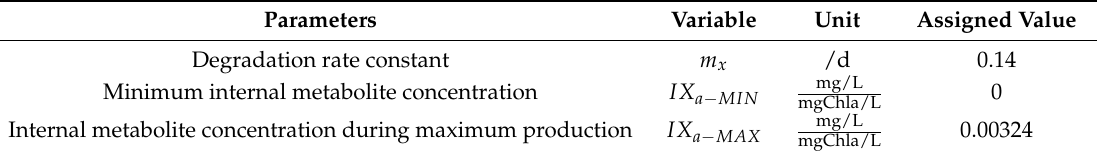
Table 5. Parameters applied for estimating algal metabolites at the Jinyang